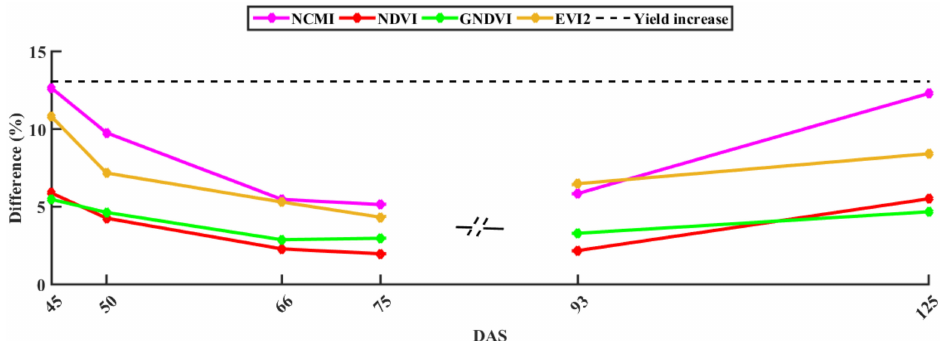
Figure 10. Percentage of difference between the control and GB for the VIs studied on each Planet date (for each date and VI, differences between control and GB are statistically significant ( p <